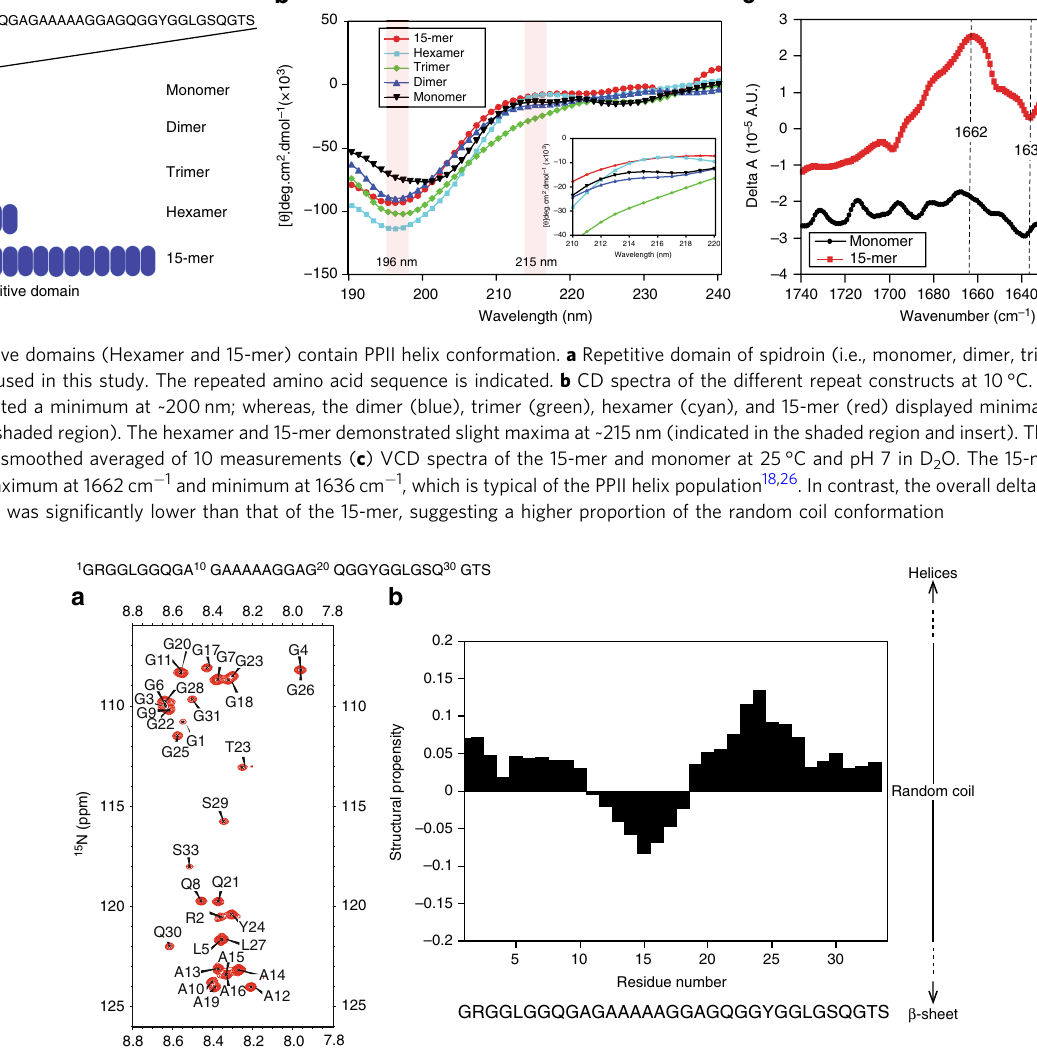
Detailed structural propensities of the repetitive domains . The concentrations of the ( 13 C, 15 N) repetitive domains of the spi- droins used for the NMR measurements were ~1.5 – 2.2 mM